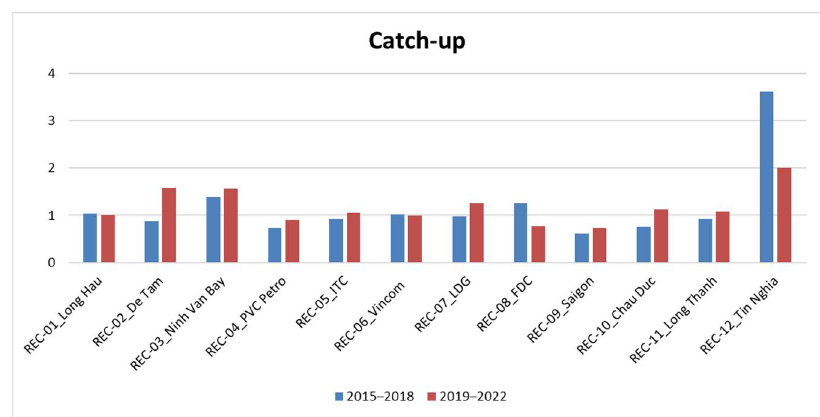
Figure 6. The comparison of technical efficiency change.